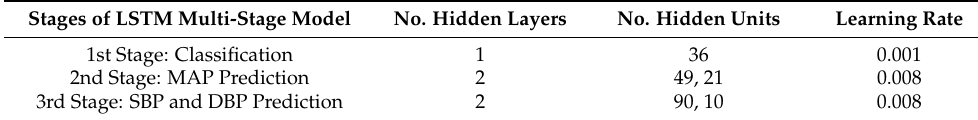
Table 7. LSTM Multi-Stage Model Design Parameters.